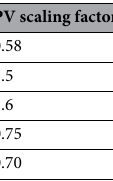
Table 1. Scaling factors for the currents of the pulmonary vein (PV) version of the base model, taken from 22